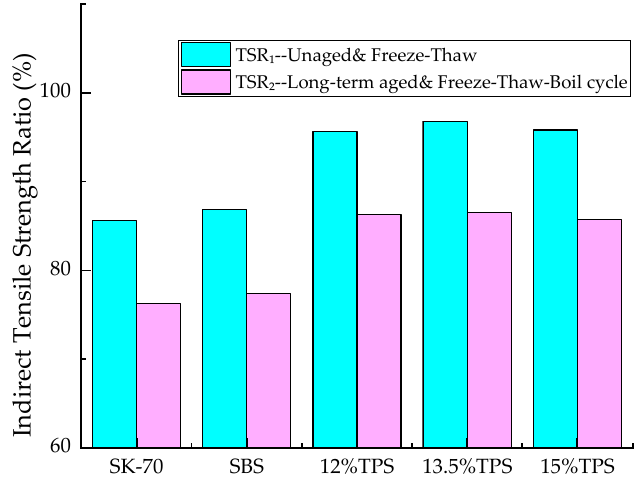
Figure 7. Results of indirect tensile tests under a freeze–thaw–boil cycle.